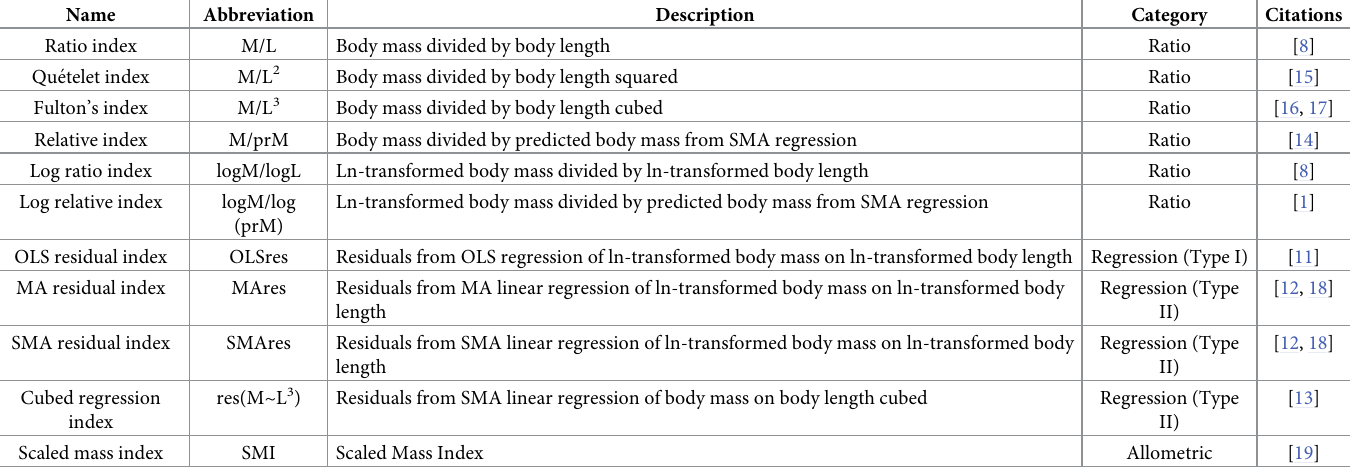
Table 1. Summary of the body condition indices (BCIs) used in this study. Naming and abbreviations follow Falk et al. [3]. Additional abbreviations indicating regres- sion types are defined as follows: standard major axis (SMA), major axis (MA), and ordinary least squares